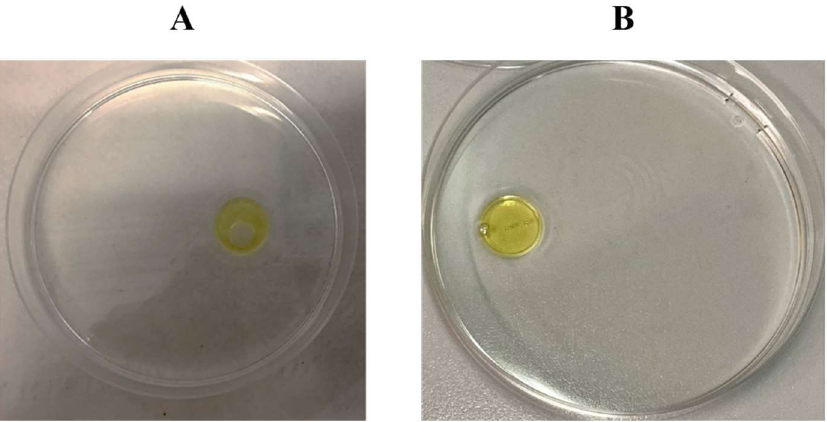
Figure 1. Oil spreading assay to evaluate the surface activity of the CFS produced by R . opacus R7 growth on M9 mineral medium supplemented with naphthalene for 48 h ( A ) and the control with water ( B ).